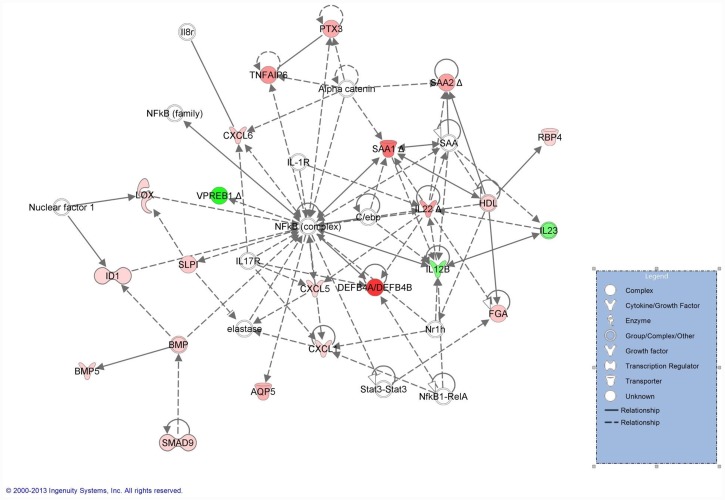
Global gene expression profile in mediastinal lymph nodes from RAO-affected horses supports an inflammatory network focused on NF-κB.The relationship between 19 of the highly expressed (focus molecules) from the microarray data set and other molecules, as derived from the Ingenuity Pathways Knowledge Base, is shown. Up-regulated genes are shown in red and down-regulated genes are in green. For molecules depicted in white, expression data were either not measured or were not significantly changed in the equine microarray data. (The networks were generated through the use of QIAGEN’s Ingenuity Pathway Analysis (IPA QIAGEN Redwood City, www.qiagen.com/ingenuity).